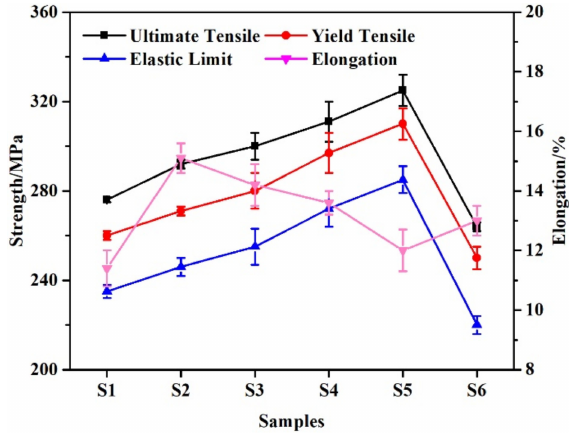
Figure 2. Room temperature tensile properties of six samples.